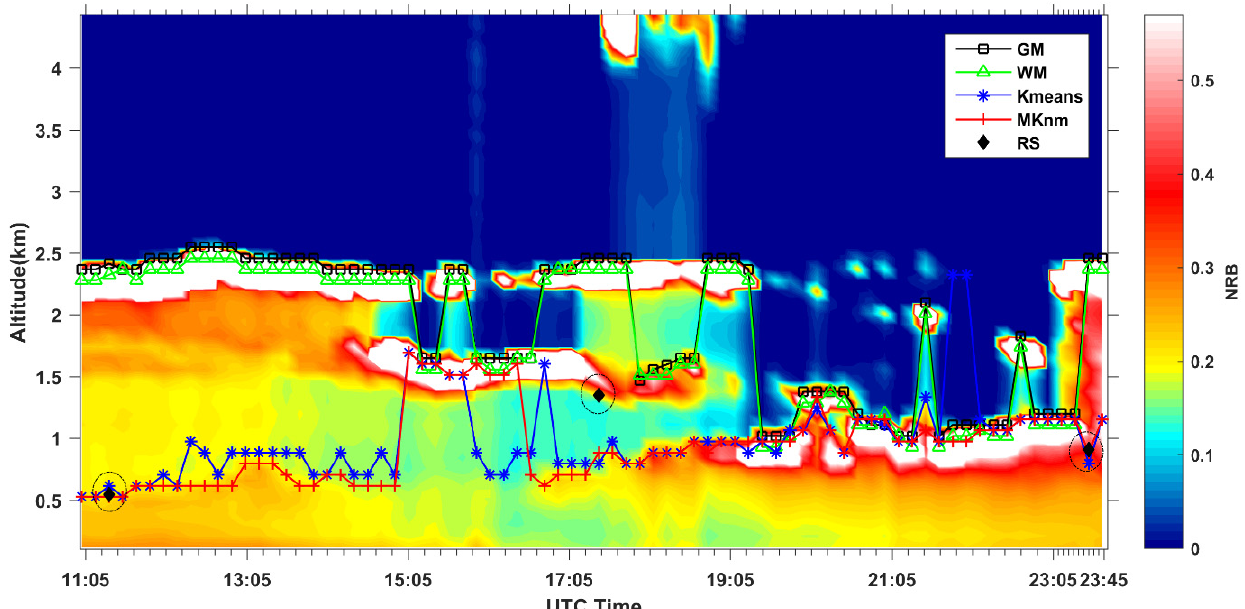
Figure 7. Resulting ABLH for 2 October 2003 with 10 min averages for all methods. Radiosonde- estimated ABLHs are shown as the black diamond.